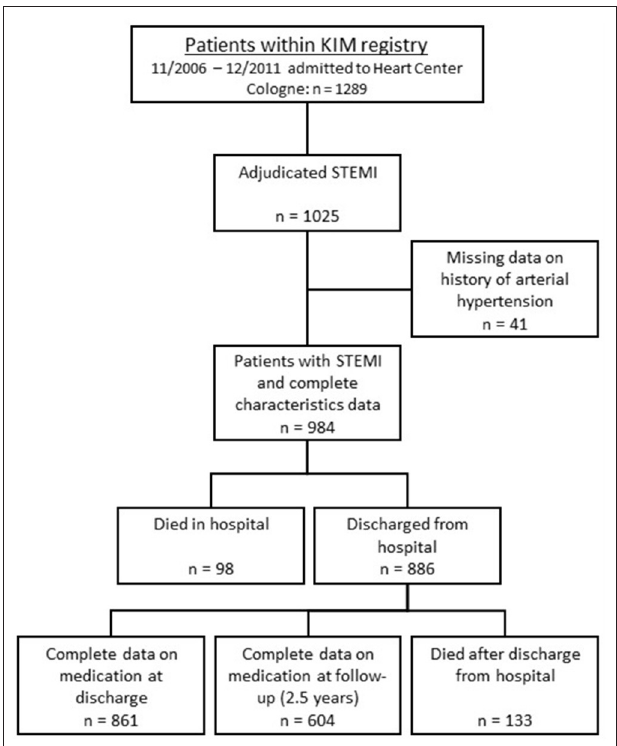
FIGURE 1 | Scheme of group distribution within the KIM-registry. KIM—Cologne Infarction Model; STEMI—ST-elevation myocardial infarction.